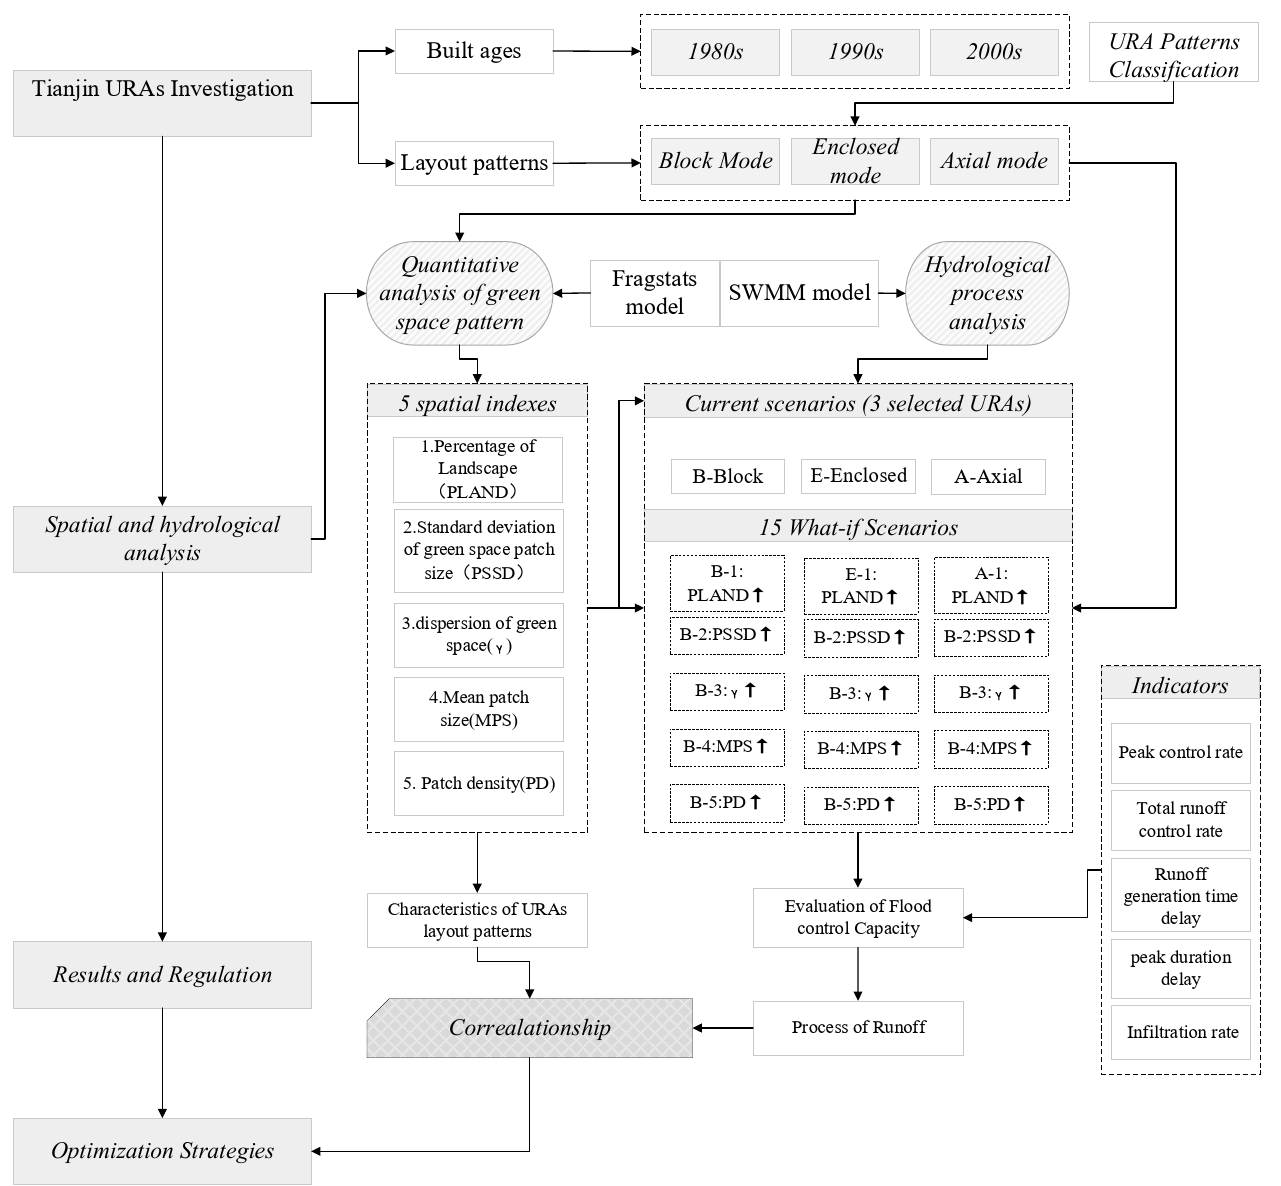
Figure 5. Workflow for this